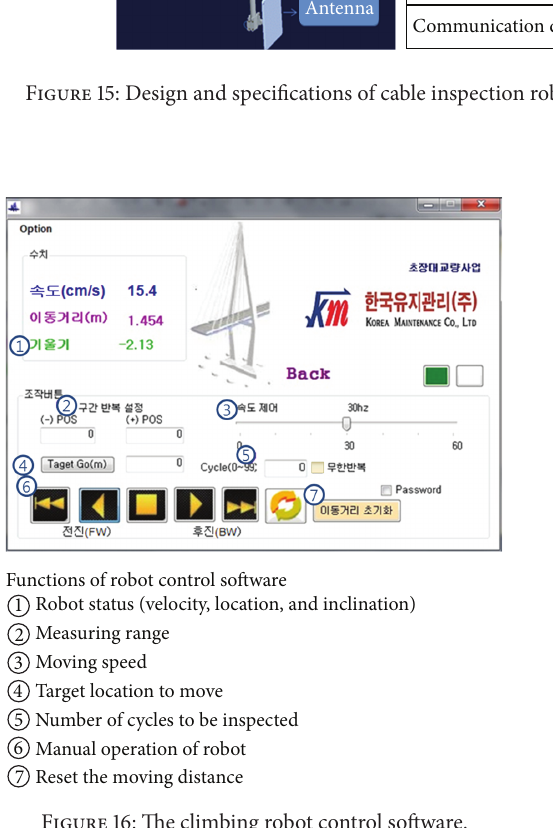
Figure 16: The climbing robot control